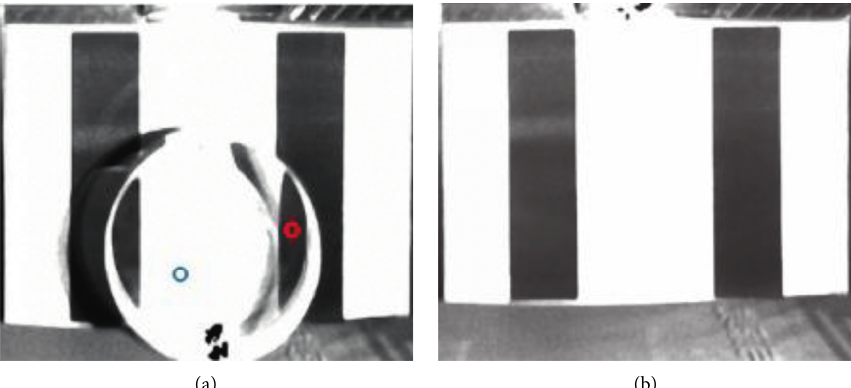
Figure 13: A Gray code image. (a) A single Gray code image with transparent objects. (b) A single Gray code image without transparent objects.